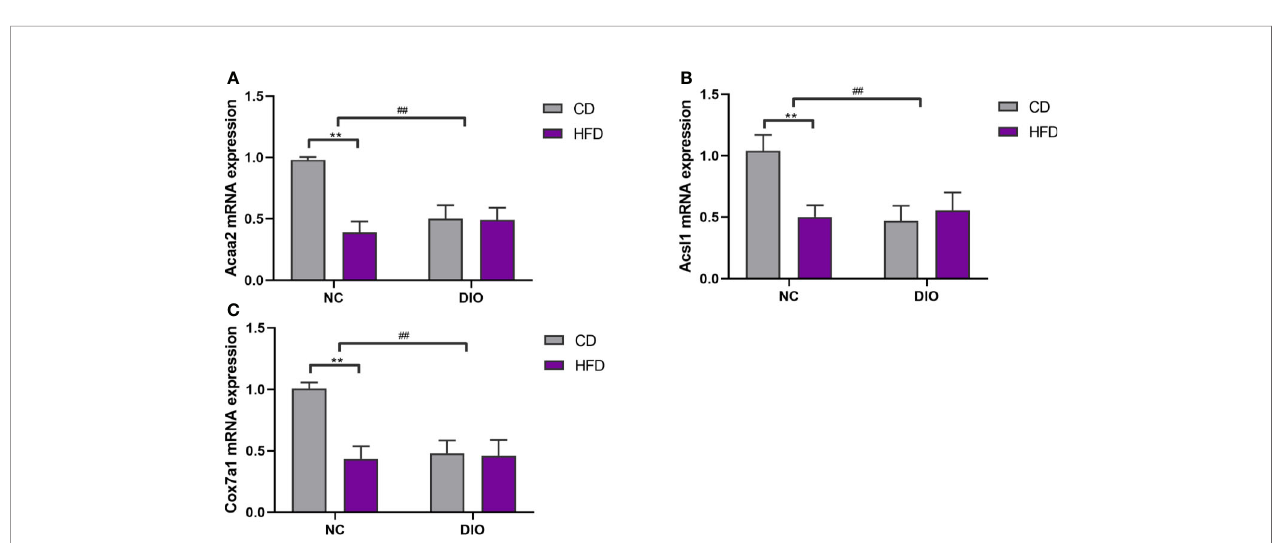
FIGURE 8 | The effect of maternal HFD reduced (A) Acaa2 , (B) Acsl1 , (C) Cox7a1 expression in male offspring BAT. Values represent the mean ± SEM, n = 8 each group. P values represent signi fi cance in the main effect for each source of variation (diet or prenatal exposure) as calculated by two-way ANOVA: ** P < 0.01 offspring diet effect, ## P < 0.01 maternal diet effect. NC, normal control; DIO, diet-induced obesity; CD, control diet; HFD, high-fat